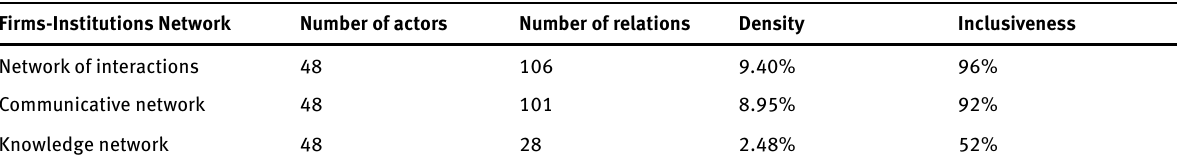
Table 3: Institutions - Firms network indexes Firms-Institutions